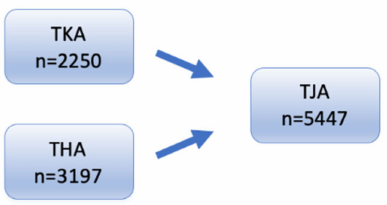
Figure 1. A total of 5447 included patients after TJA from 2013 to 2020. TKA = total knee arthro- plasty/THA = total hip